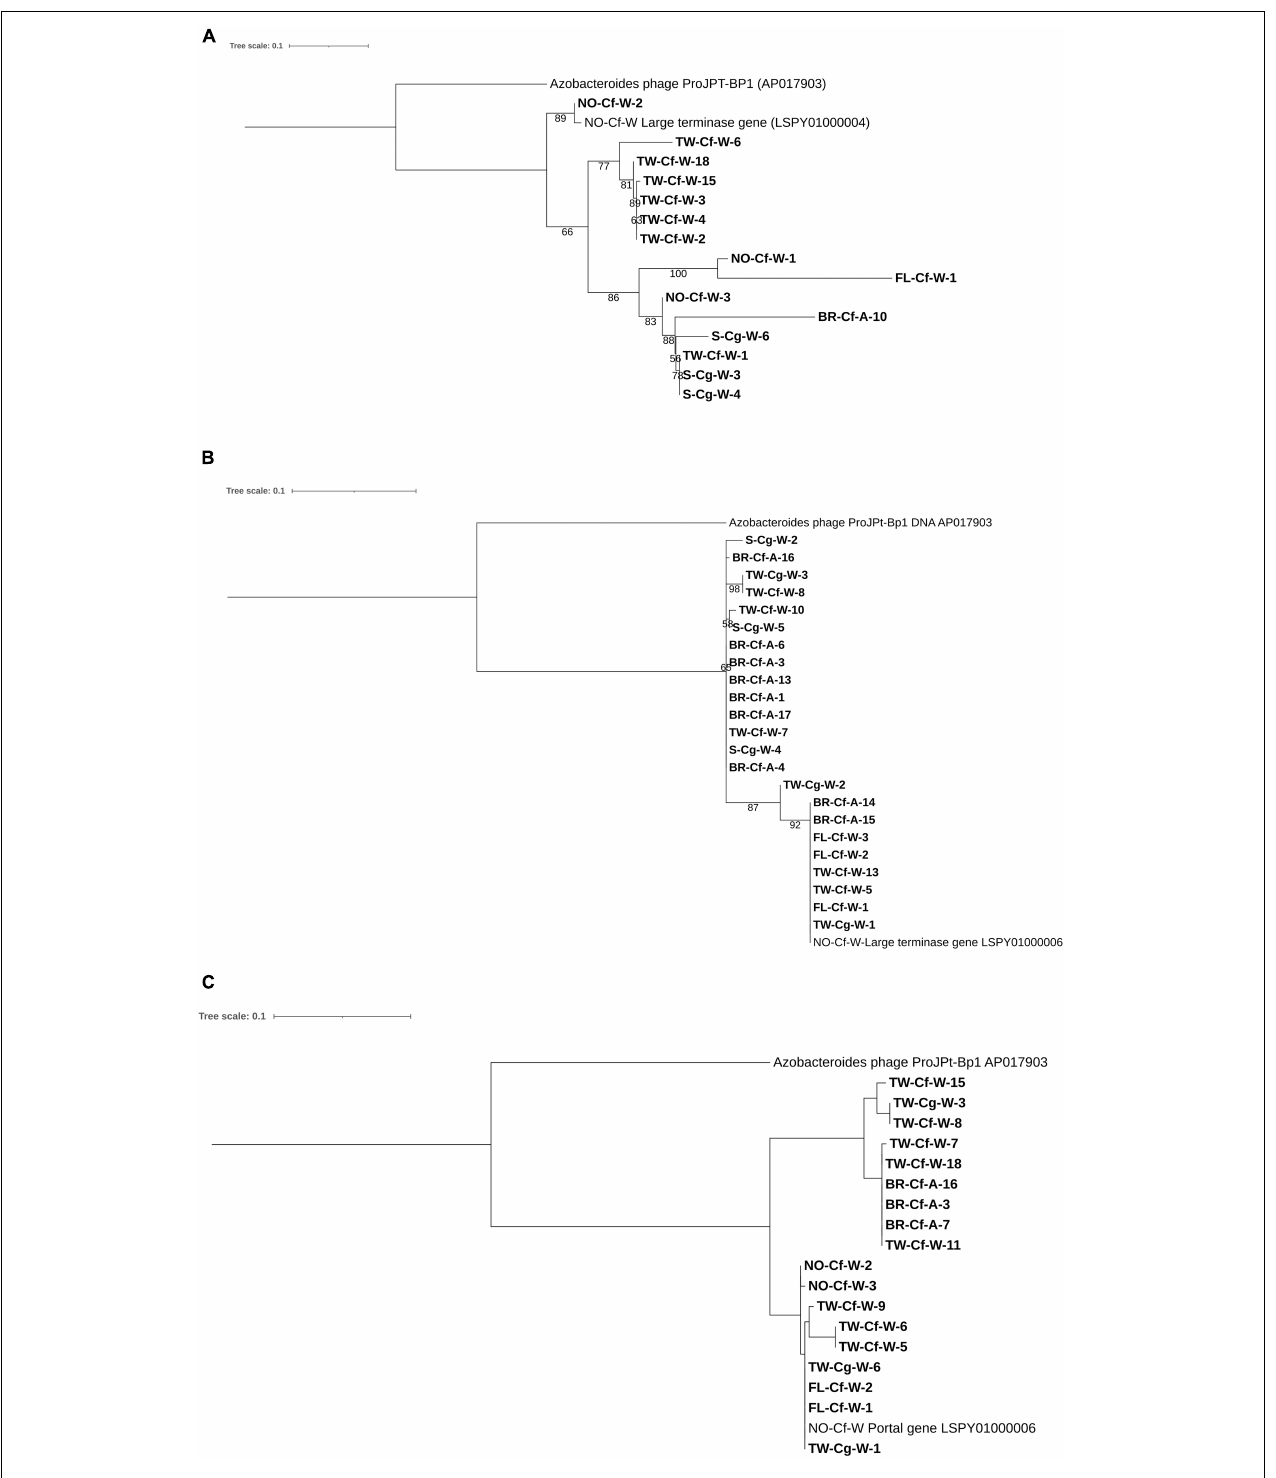
FIGURE 4 | Maximum likelihood trees of (A) Phage TG-crAlp-04 Terminase gene, (B) Phage TG-crAlp-06 Terminase gene and (C) Phage TG-crAlp-06 Portal Protein gene sequences. Support values were obtained from 1,000 bootstrap replications; values greater than 50% are shown. Sample names in bold indicate samples collected in this study and consist of location [TW (Taiwan), S (Saipan), FL (Florida, United States), NO (New Orleans, LA, United States), BR (Baton Rouge, LA, United States)], termite species [Cf ( Coptotermes formosanus ), Cg ( Coptotermes gestroi )], and caste [W (worker) and A (alate)]. Sequences for the Azobacteroides phage from P. japonicus (Pramono et al., 2017) and Phage TG-crAlp-04 and TG-crAlp-06 from the C. formosanus metavirome (Tikhe and Husseneder, 2018) were retrieved from NCBI database and included as references.